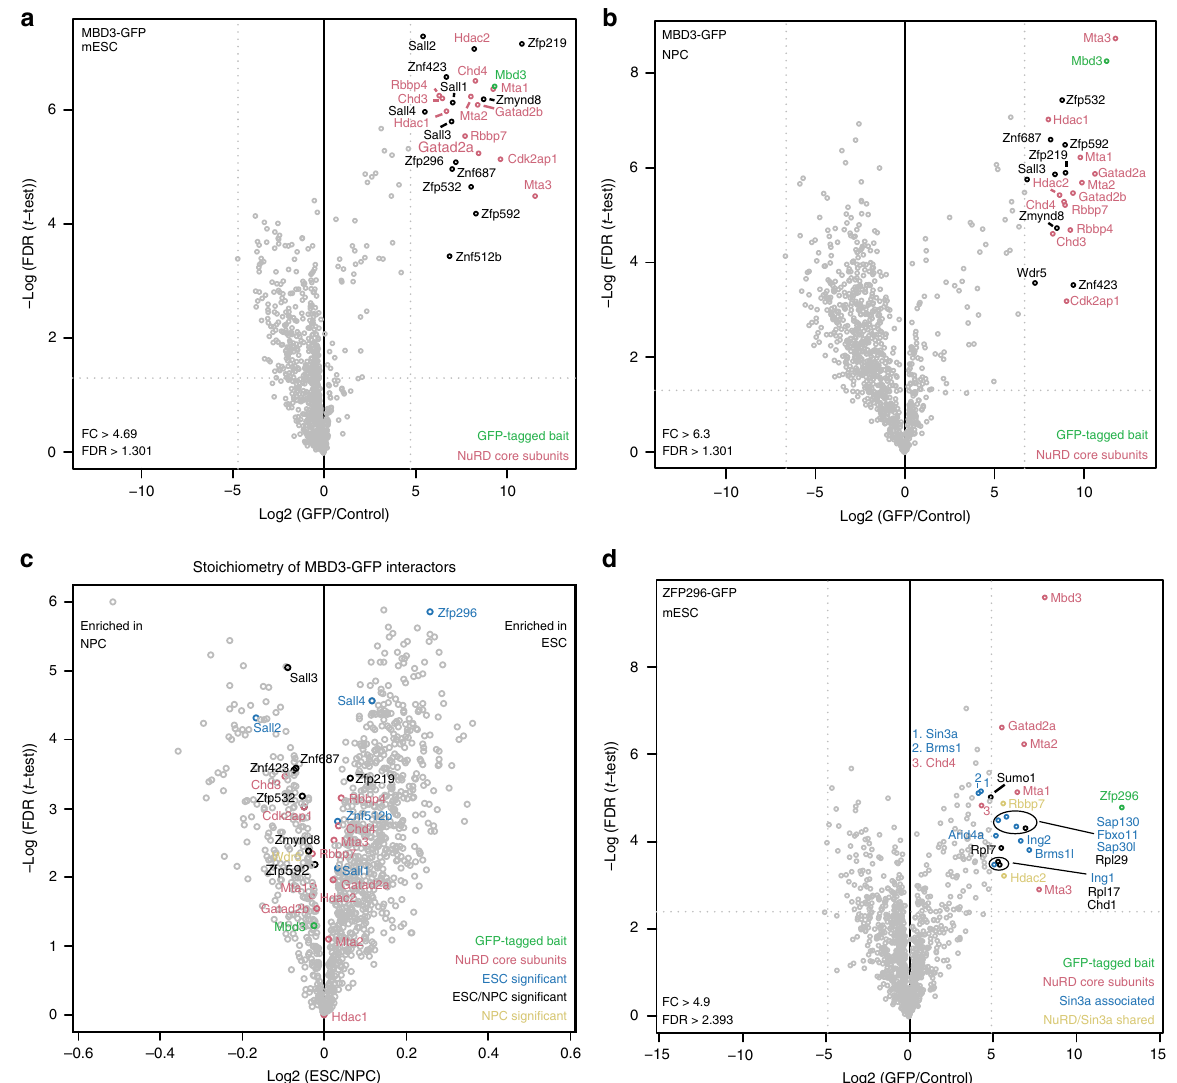
Fig. 2 ZFP296 is an ESC-speci fi c NuRD interactor. a , b Volcano plots from label-free GFP pulldowns on MBD3-GFP ESC ( a ) and MBD3-GFP NPC ( b ) nuclear extracts. Statistically enriched proteins in the MBD3-GFP pulldowns are identi fi ed by a permutation-based FDR-corrected t -test. The label-free quanti fi cation (LFQ) intensity of the GFP pulldown relative to the control [fold change (FC), x -axis] is plotted against the − log 10 -transformed P -value of the t -test ( y -axis). The proteins in the upper right corner represent the bait (MBD3, green) and its interactors. NuRD core subunits are colour-coded in red. c Volcano plot of the stoichiometry of MBD3-GFP interactors in ESCs and NPCs. The iBAQ value of each protein group is divided by the iBAQ value of the core NuRD subunit HDAC1/2, then graphed as in a . Proteins that were identi fi ed as signi fi cant outliers in a or b are colour-coded in blue or yellow, respectively, and those that were signi fi cant in both are in black. d Volcano plot of GFP-ZFP296 interacting proteins in ESCs graphed as in a . NuRD core subunits are colour-coded in red, SIN3A associated proteins are in blue, and proteins that are shared subunits between NuRD and SIN3A are in yellow. See also Supplementary Fig.